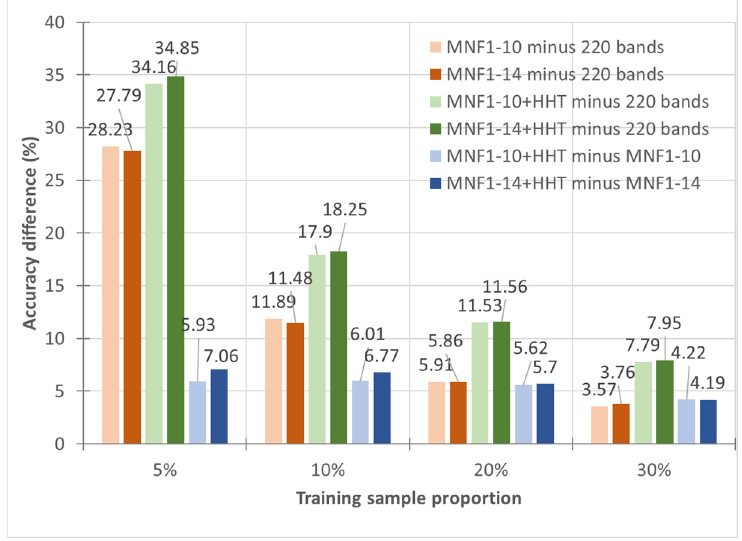
Figure 4. Accuracy comparisons between the original 220 band IP dataset, the MNF-transformed image sets, and the MNF+HHT-transformed image sets.